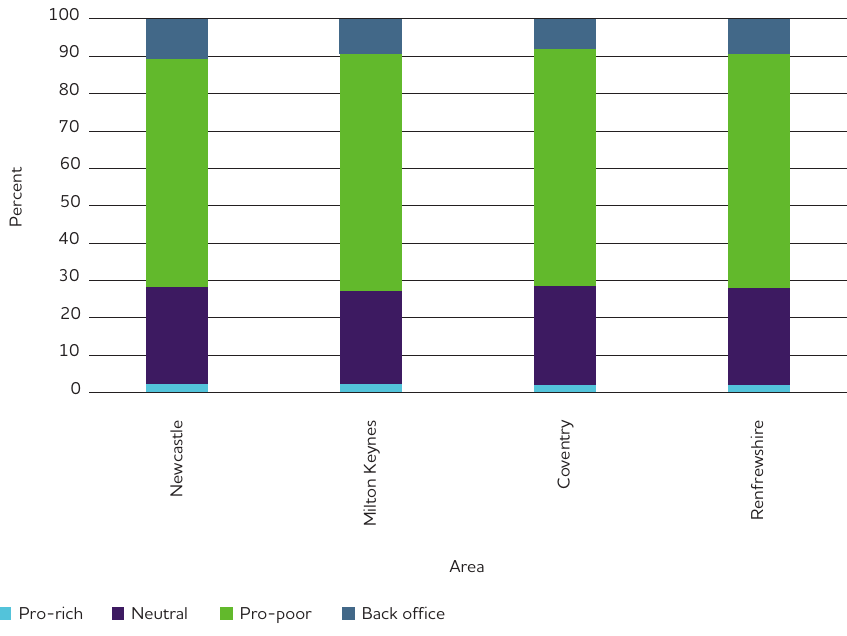
100 The cost of the cuts: the impact on local government and poorer communities